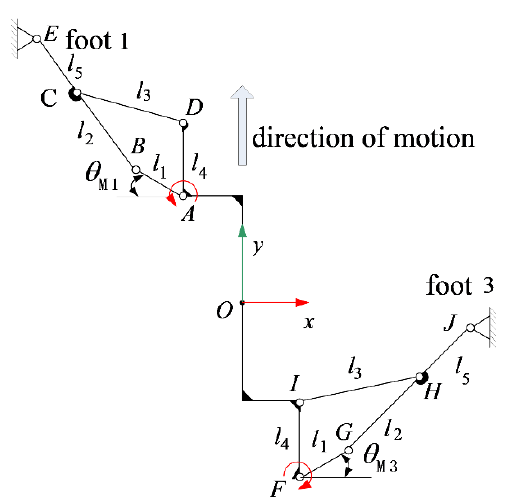
Figure 3. Analysis of the mechanism when the robot walked straight